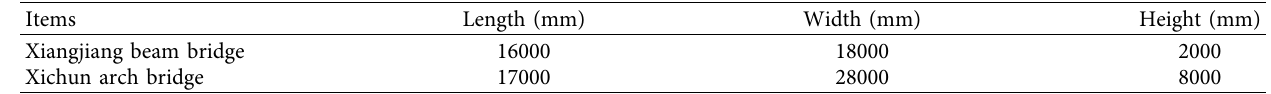
Figure 8: The UAV approaching actual bridge, (a) the side of beam bridge, (b) the bottom of beam bridge, (c) the side of arch bridge, and (d) the bottom of arch bridge. Table 10: The parameters of actual bridge.